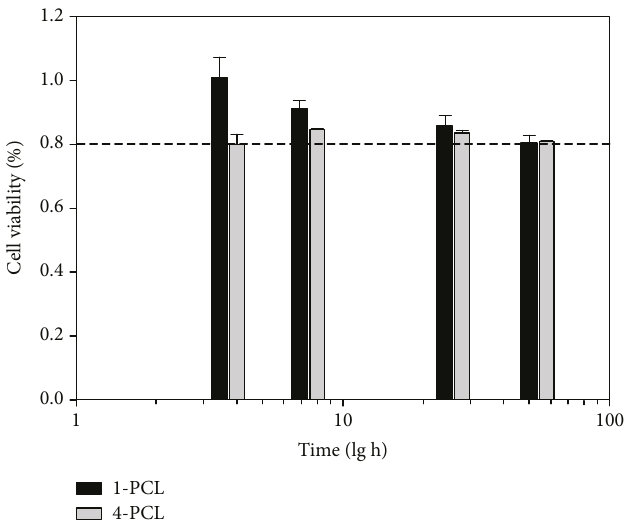
Figure 7: Cytotoxicity of ropivacaine-loaded PCL microspheres to L929 cells (CCK-8